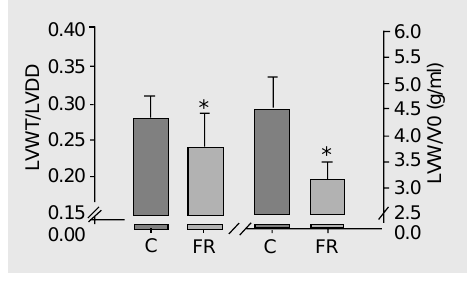
Figure 2. Left ventricular dia- stolic function evaluated in the isolated heart. Data are reported as means ± SD for 9 animals in each group. C = control group; FR = food-restricted group; ε 25 = percentage of myocardial strain caused by a diastolic stress of 25 g/cm 2 ; ∆ V 25 = per- centage of variation in ventricu- lar volume required to increase diastolic pressure from 0 to 25 mmHg. Note that both ordinates and abscissa are discontinuous. *P < 0.05 compared to control animals (Student t -test).